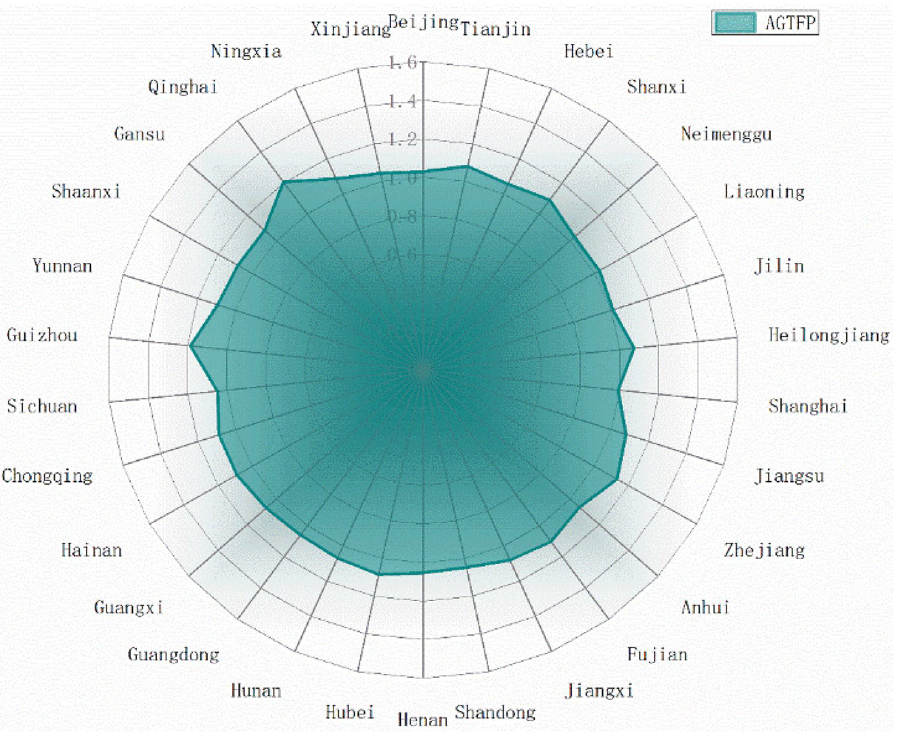
Figure 2. Spatial heterogeneity of AGTFP in 30 provinces.